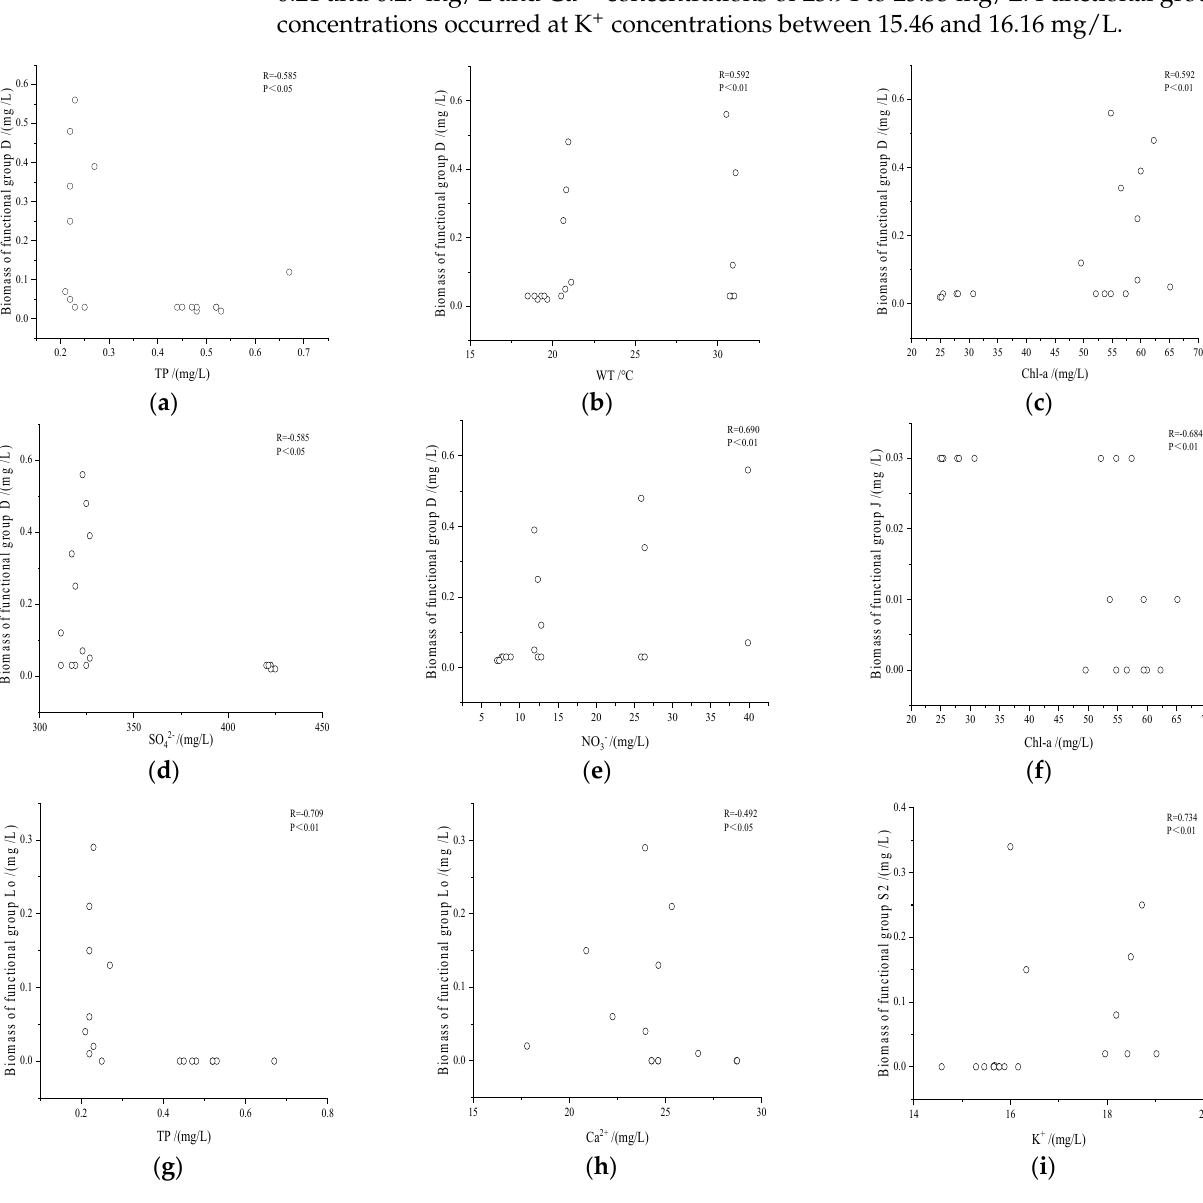
Figure 8. Relationship between biomass of dominant functional groups of phytoplankton and some water environmental factors (TP, WT, Chl − a, SO 42 − , NO 32 − , Ca 2+ , and K + ) in Nanhai Lake. Notes: ( a ): relationship between biomass of functional group D and TP; ( b ): relationship between biomass of functional group D and WT; ( c ): relationship between biomass of functional group D and Chl − a; ( d ): relationship between biomass of functional group D and SO 42 − ; ( e ): relationship between biomass of functional group D and NO 32 − ; ( f ): relationship between biomass of functional group J and Chl − a; ( g ): relationship between biomass of functional group Lo and TP; ( h ): relationship between biomass of functional group Lo and Ca 2+ ; ( i ): relationship between biomass of functional group S2 and K + .